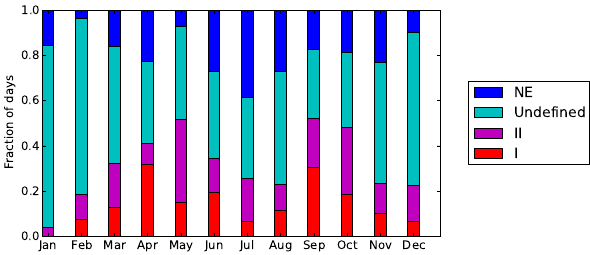
Figure 2. The fraction of days in each month classified as having class I, II and undefined events as well as days with no events (NE). Some days did not have at least 75% of the day with SMPS data and were not used. All months had at least 22 classified days. Note that multiple undefined events may occur on a given undefined event day. Undefined events may also occur on class I or class II event days; however, these are counted as class I or II